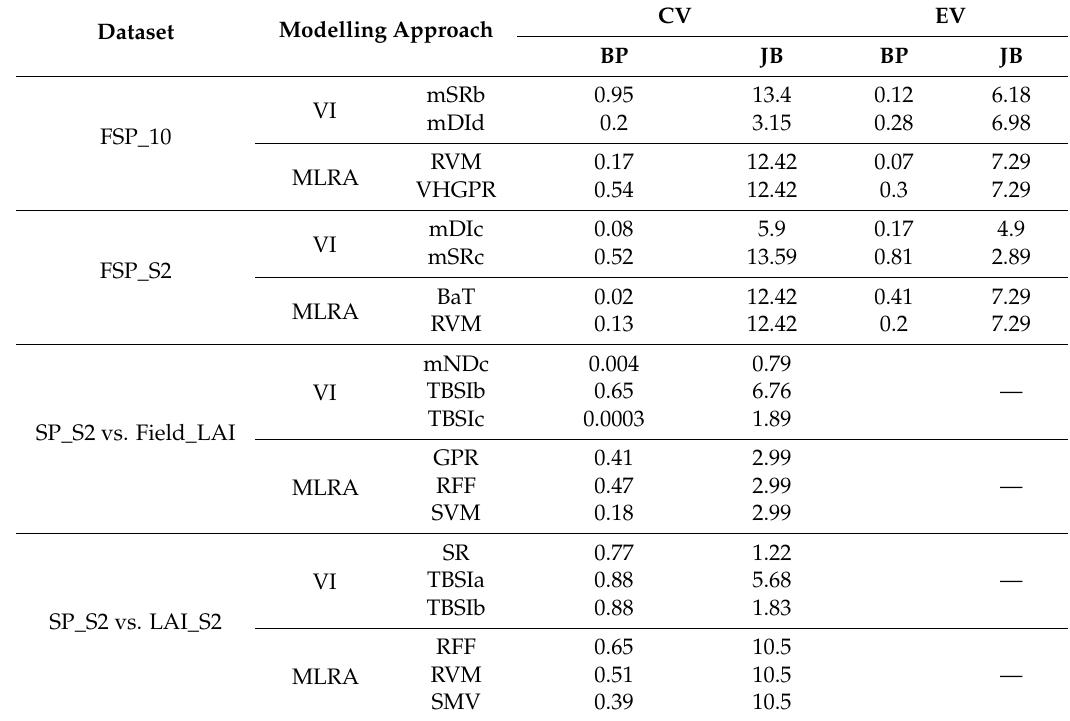
Table A2. Diagnostic of homoscedasticity and residual